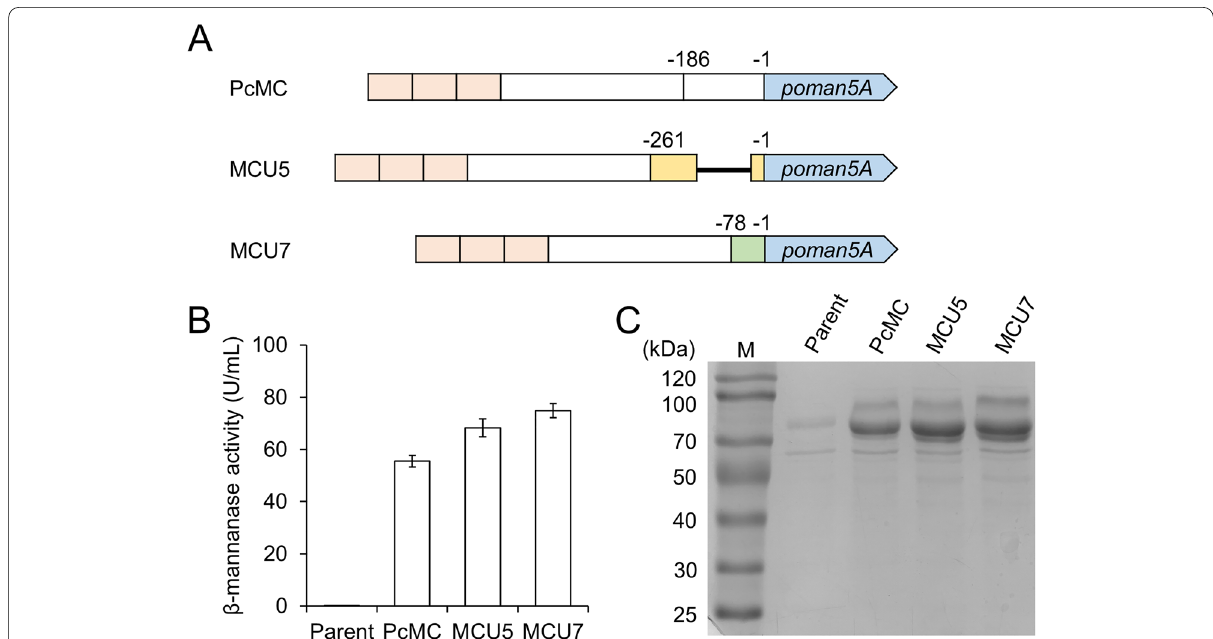
Fig. 2 Engineering of the 5 ′ -untranslated region of cdna1 promoter. A Schematic representation of the 5 ′ -UTR replaced promoters. Yellow and green boxes indicate 5 ′ -UTRs from cel5A and cel7A promoters, respectively. The 123-bp intron in the UTR of cel5A is indicated by a thick line. B Extracellular β-mannanase activities of strains expressing poman5A with different promoters at 48 h. Data represent mean cultivations. C SDS-PAGE analysis of the culture supernatants analyzed in panel